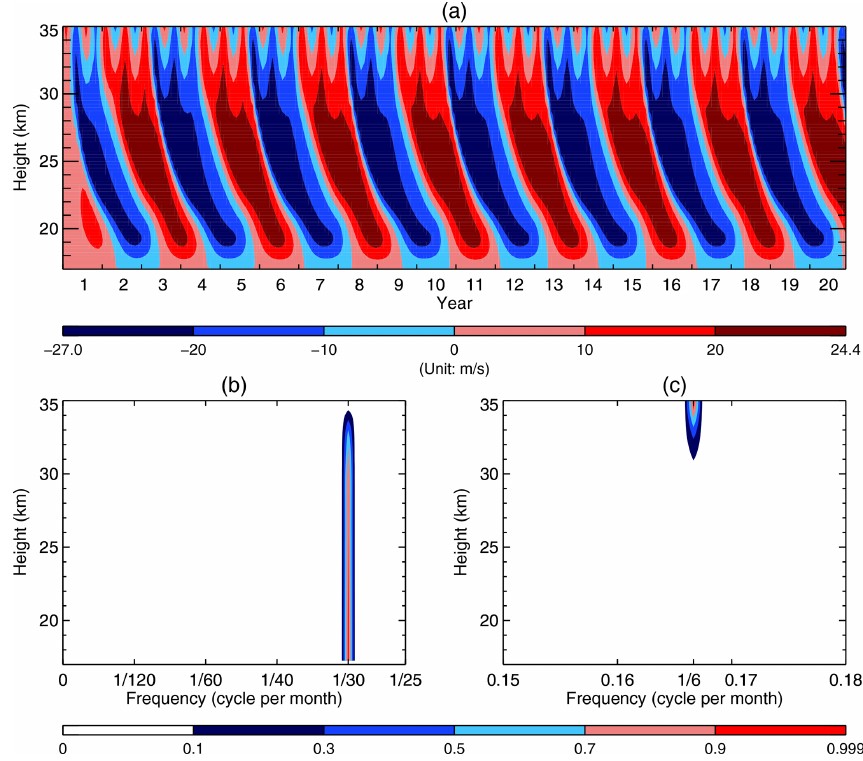
Figure 2. (a) Time–height section of the monthly averaged mean zonal wind over the first 20 years from the HL’s original model. (b, c) Frequency–height section of the power spectral densities (PSDs) of the standardized monthly averaged mean zonal wind of the 100 years. Note that in order to better visualize the PSDs in (b) and (c) , we trimmed off the blank segments for the frequencies ranging from 1 0.15 cycles per month and those ranging from 0.18 to 0.5 cycles per